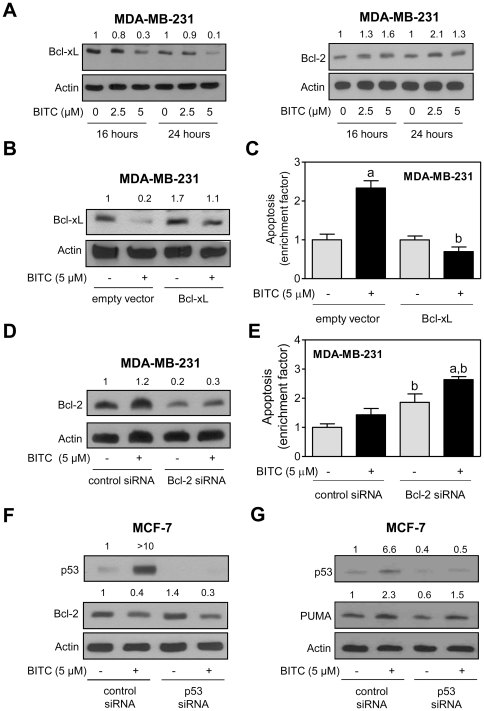
Opposing effect of BITC treatment on levels of Bcl-xL and Bcl-2 proteins in MDA-MB-231 cells.(A) Western blotting for Bcl-xL and Bcl-2 using lysates from MDA-MB-231 cells treated with DMSO (control) or BITC (2.5 or 5 µM) for the indicated time periods. Number above band indicates change in level compared to the corresponding DMSO-treated control. (B) Western blotting for Bcl-xL and (C) quantitation of histone-associated DNA fragment release into the cytosol in MDA-MB-231 cells transiently transfected with empty vector or vector encoding for Bcl-xL and treated for 24 h with DMSO or 5 µM BITC. Results are expressed as enrichment relative to corresponding DMSO-treated control. Data represent mean ± SD (n = 3). Significantly different (P<0.05) acompared with corresponding DMSO-treated control, and bbetween empty vector transfected cells and Bcl-xL overexpressing cells by one-way ANOVA followed by Bonferroni's multiple comparison test. (D) Western blotting for Bcl-2 and (E) quantitation of histone-associated DNA fragment release into the cytosol in MDA-MB-231 cells transiently transfected with a control siRNA or the Bcl-2-targeted siRNA and treated for 24 h with DMSO or 5 µM BITC. In panel E, results shown are relative to control siRNA transfected cells treated with DMSO. Data represent mean ± SD (n = 3). Significantly different (P<0.05) acompared with corresponding DMSO-treated control, and bbetween control siRNA transfected cells and Bcl-2 siRNA transfected cells by one-way ANOVA followed by Bonferroni's multiple comparison test. (F) Western blotting for p53 and Bcl-2 using lysates from MCF-7 cells transiently transfected with a control siRNA or the p53-targeted siRNA and treated for 24 h with DMSO or 5 µM BITC. (G) Western blotting for p53 and PUMA using lysates from MCF-7 cells transiently transfected with a control siRNA or the p53-targeted siRNA and treated for 24 h with DMSO or 5 µM BITC. Number above the bands in 5F, G represents change in level relative to control siRNA transfected cells treated with DMSO. All the experiments were repeated at least twice and representative data from one such experiment are shown.